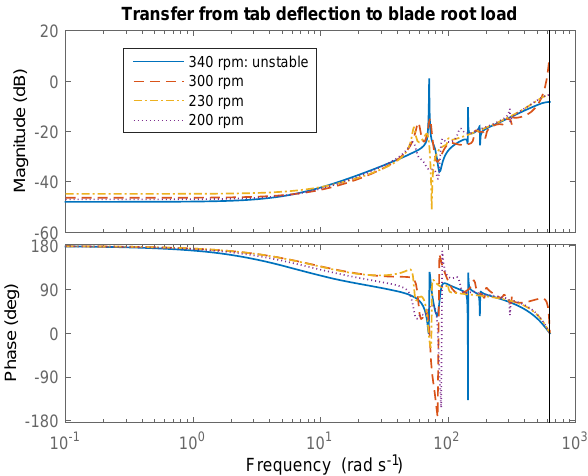
Figure 13. Transfer from piezobender actuators to blade root loads at different wind speeds.